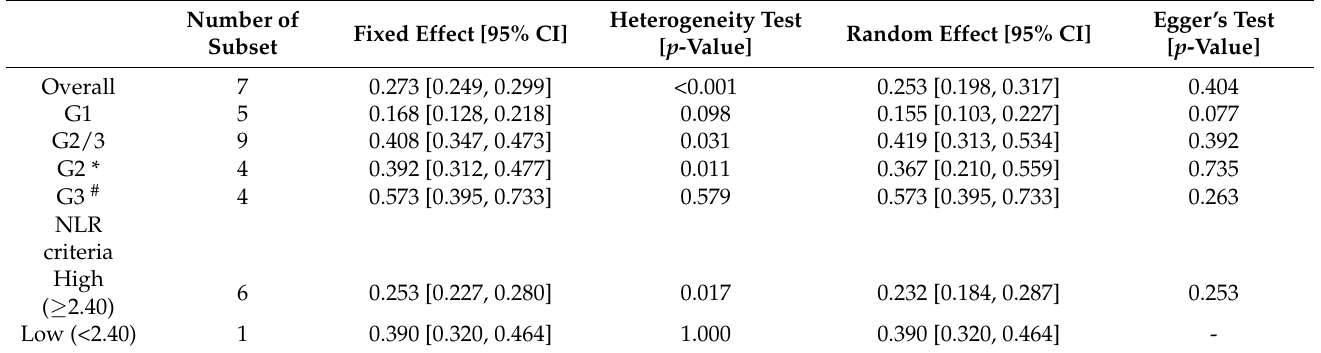
Table 2. Estimated rate of higher value of neutrophil-to-lymphocyte ratio (NLR) in pancreatic neuroendocrine tumors.